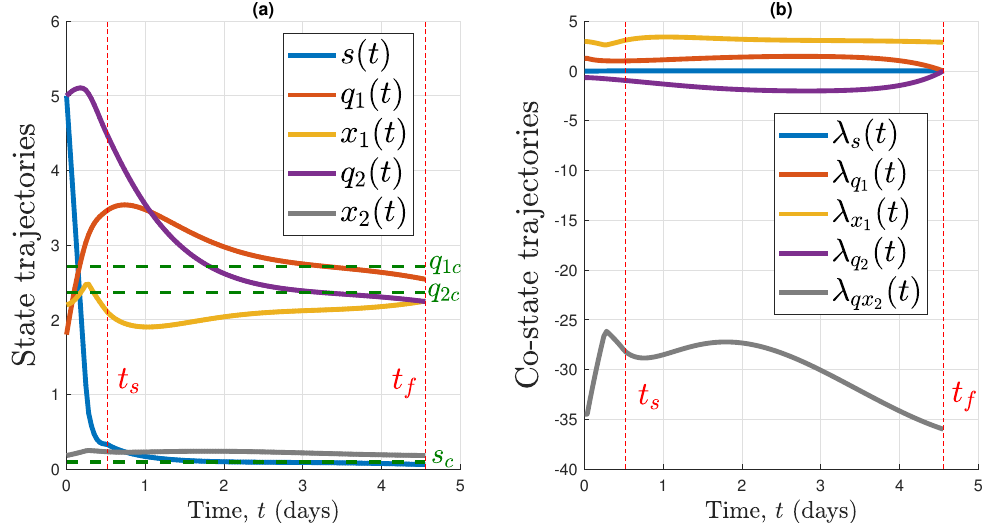
Figure 12. The optimal model trajectories ( a ), and the optimal co-state trajectories ( b ) that satisfy the transversality